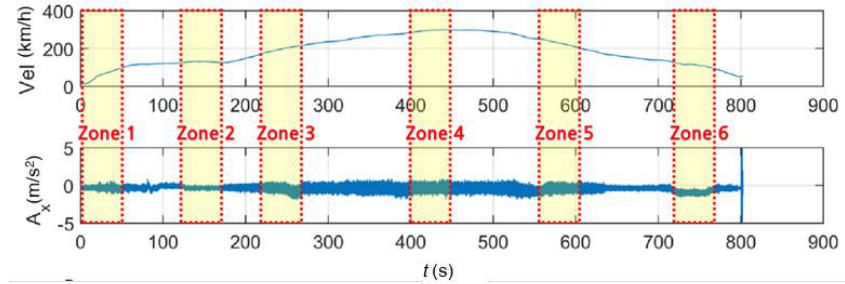
Figure 21. Zones selected from earthquake data superimposed with train data.